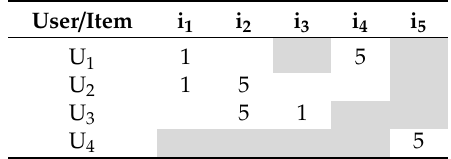
Table 1. User-item rating database